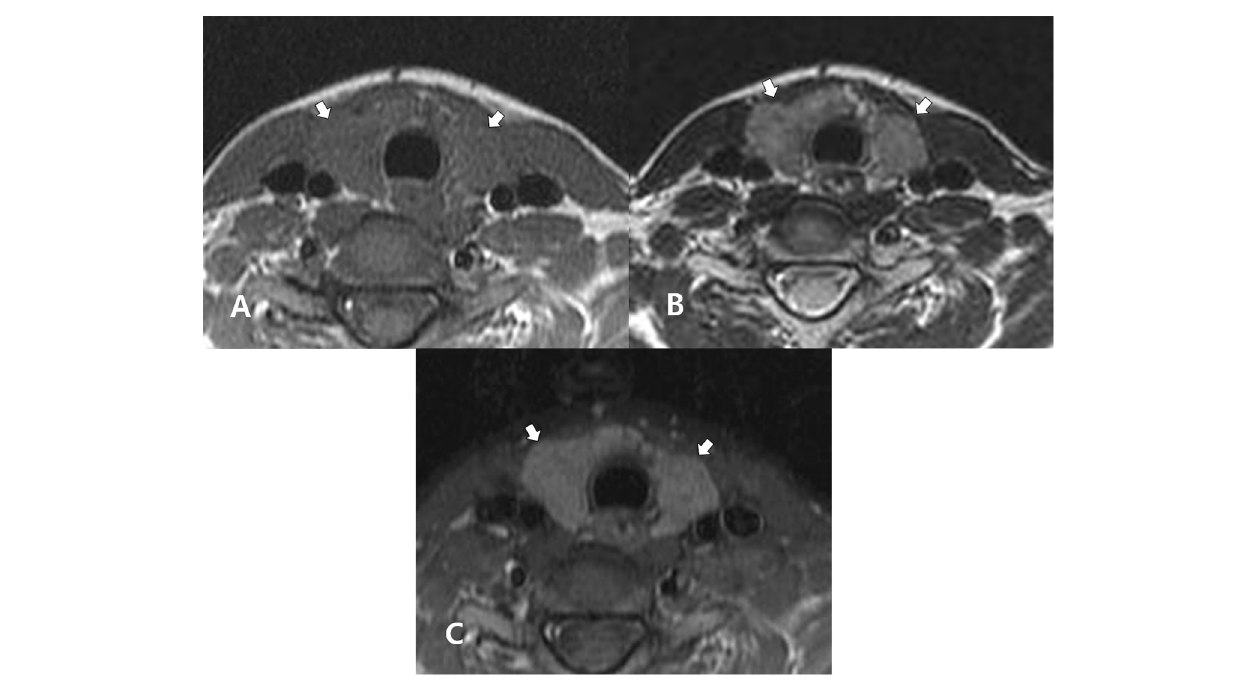
FIGURE 2 | A 27-year-old woman with Hashimoto thyroiditis confirmed in cytology after ultrasound-guided fine-needle aspiration. In the non-enhanced axial T1- (A) and T2- (B) weighted images, the thyroid gland (arrows) exhibits homogeneous, iso-signal intensity, and inhomogeneous, high signal intensity, respectively, when compared with adjacent muscle. In both images, the thyroid gland (arrows) exhibits a normal gland size and smooth margin. In the enhanced axial, fat-suppression T1-weighted image (C) , the thyroid gland (arrows) exhibits homogeneously increased enhancement, when compared with adjacent